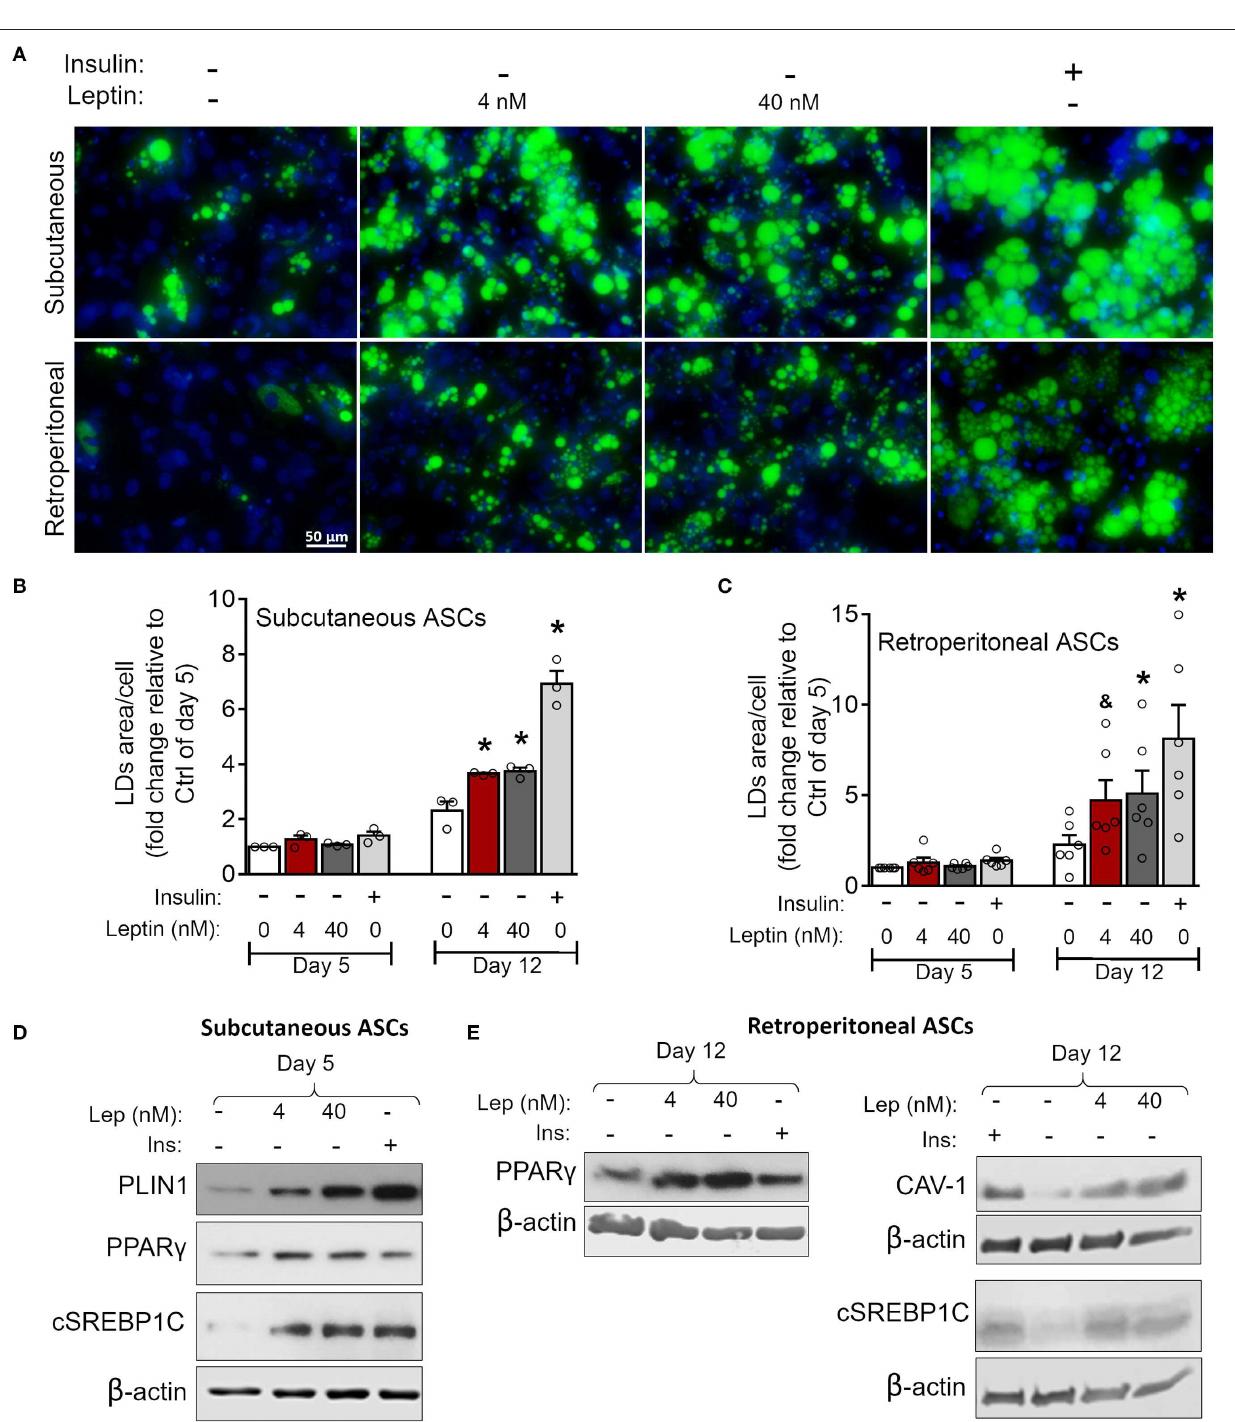
Frontiers in Endocrinology | www.frontiersin.org